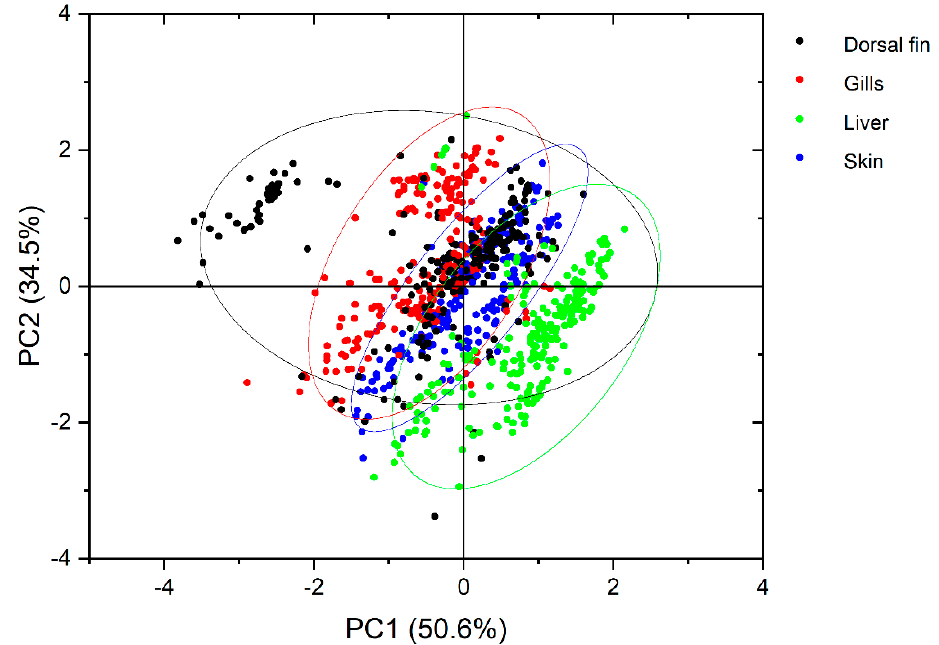
Figure 4. Principal component analysis (PCA) biplot of the classification of matrices based on the log-transformed concentrations (ng/g) of DIY and 8OHDG.